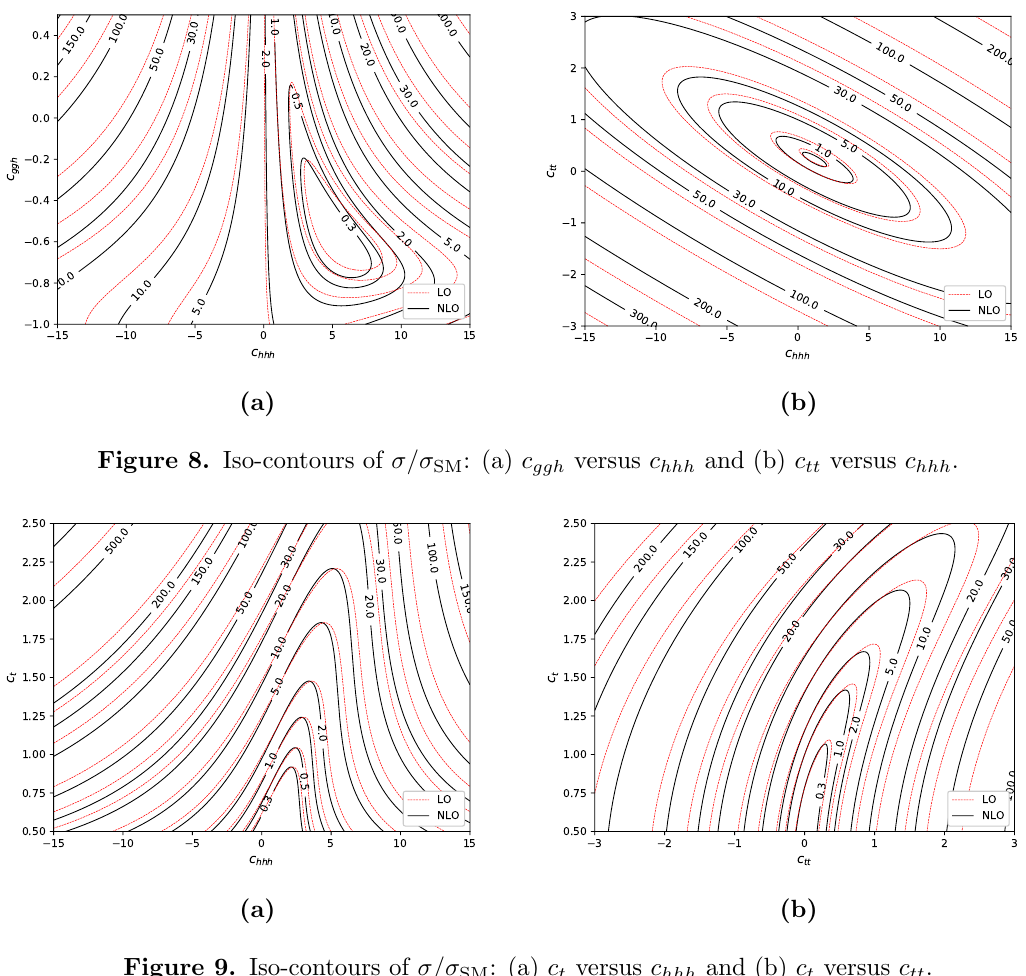
Figure 9. Iso-contours of (cid:27)=(cid:27) SM : (a) c t versus c hhh and (b) c t versus c tt